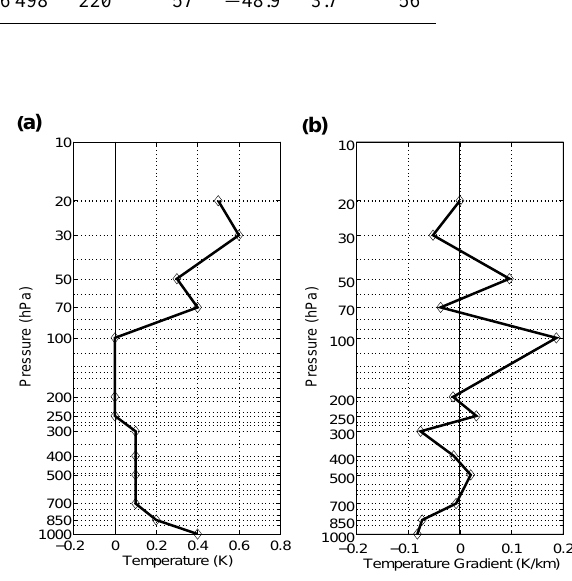
Fig. 1. Profiles of the differences between the population and the sample. (a) Differences of the mean temperatures, (b) Differences of the vertical temperature gradient.